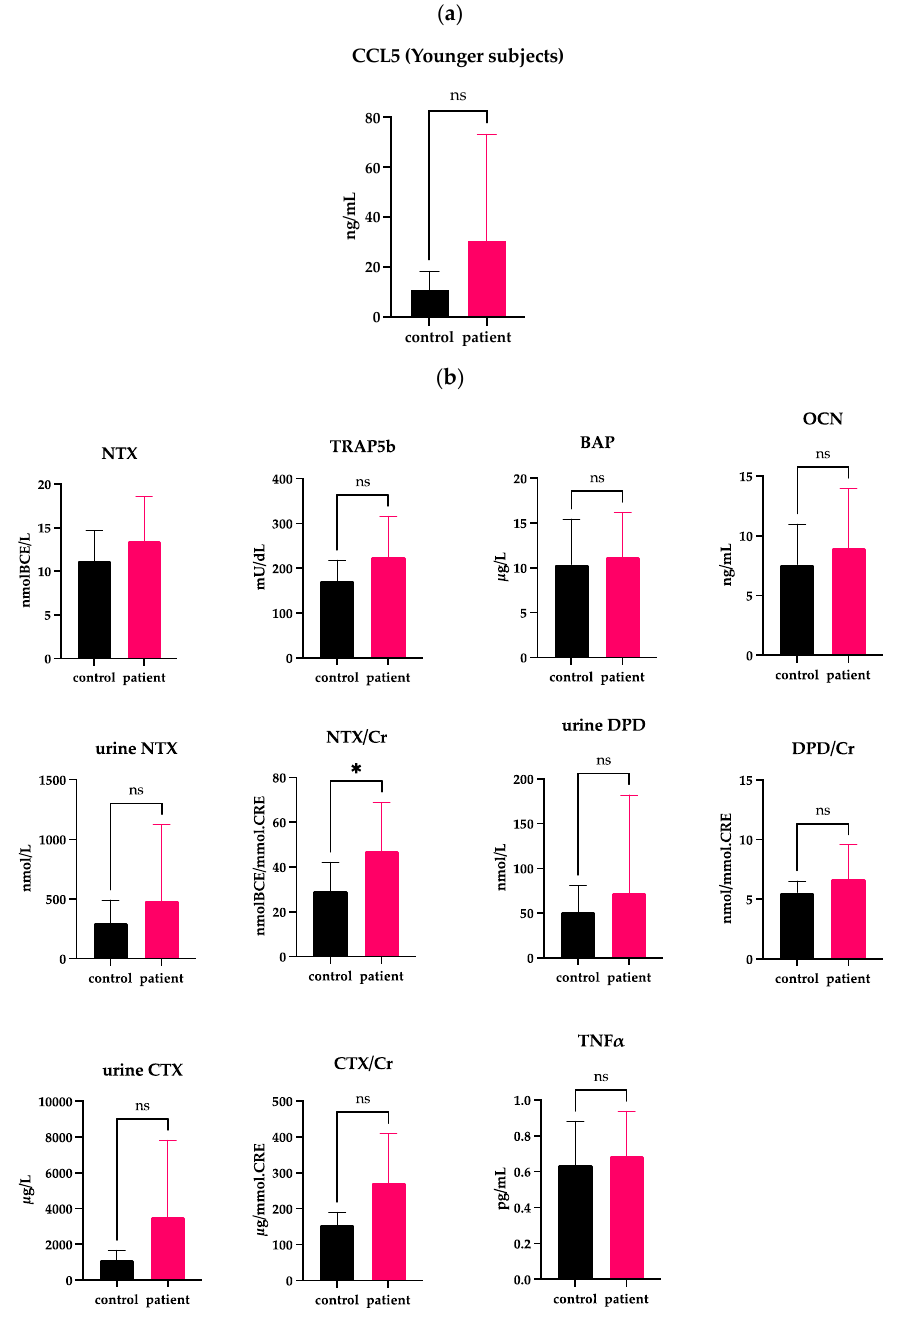
Figure 3. Measurement of CCL5 and other markers in the serum or urine obtained from subjects at ≤ 42 years old (Younger subjects). ( a ) Serum CCL5 levels are significantly higher in the group of DJD-TMJ subjects ≤ 42 years old (n = 10) than in the age-matched control groups (n = 11). ( b ) Serum or urine markers related to bone metabolism and inflammation were compared between the corresponding control groups (n = 11) and the group of DJD-TMJ subjects ≤ 42 years old (n = 10). t -test, two-tailed. * Indicates a significant difference at p < 0.05.